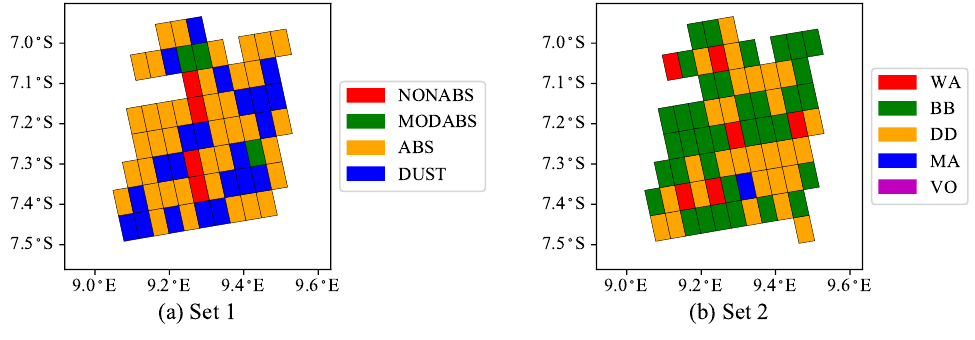
Figure 12. The same as in Figure 9 but for the data on 5 July